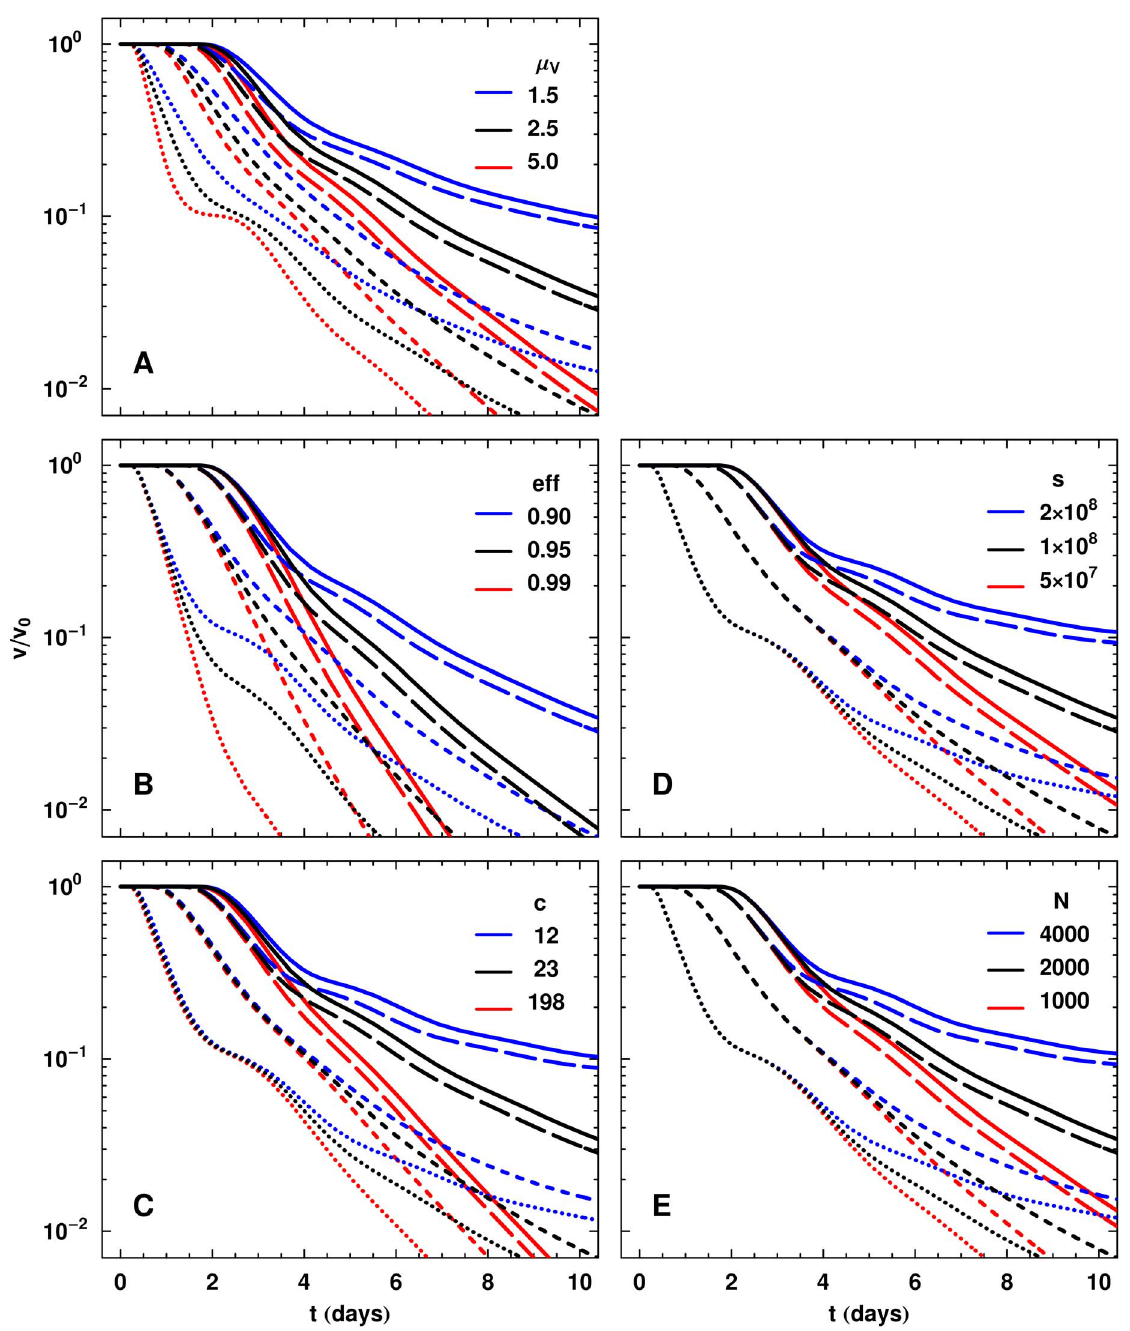
Figure 6. Comparison of pVL dynamics when individual model parameters are altered. Parameters are modified from those in Table 1, while all other parameters are held constant. (A) From this panel we can see that the productively infected cell death rate m V can control the slope in phase IA and the relative difference between phase IA slopes. (B) As efficacy eff is changed, the phase IA slope is not strongly altered. However, the length of phase IA and the start of phase IB at V = V 0 * (1 { eff) are dependent on eff . (C) Modifying the viral clearance rate c changes the initial delay slightly, but does not substantially modify phase IA. After the transition to phase IB, c influences the decay considerably. (D) The production rate of uninfected CD4 + T cells s , and (E) virion production rate per productively infected CD4 + T cell N . Both s and N do not modify the time delays or phase IA, but affect phase IB. Efficacy is set to 0.90 in (A) and (C)–(E).